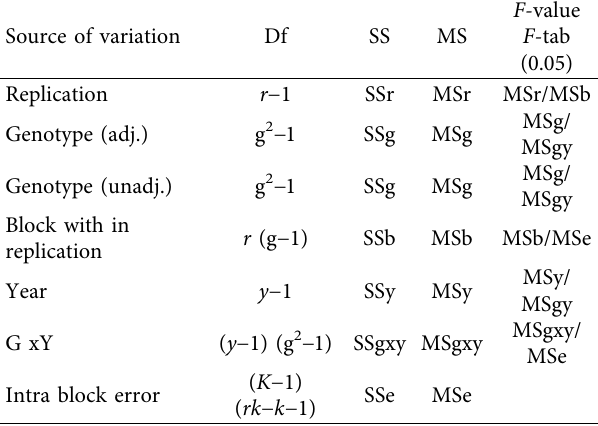
Table 3: Combined analysis of variance for over years. Source of variation